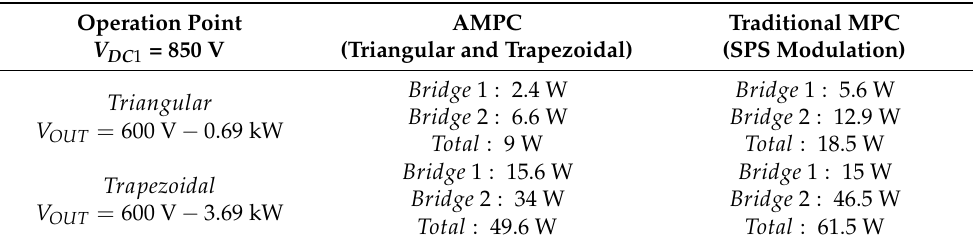
Table 4. Losses in primary and secondary bridges of DAB for AMPC and Traditional MPC in boost mode.